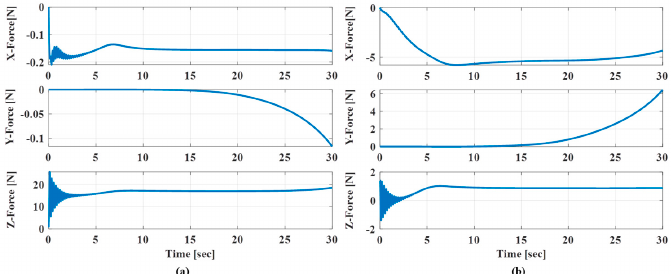
Figure 24. Forces generated by the underwater cable: ( a ) Forces acting on the USV; ( b ) Forces acting on the UUV.